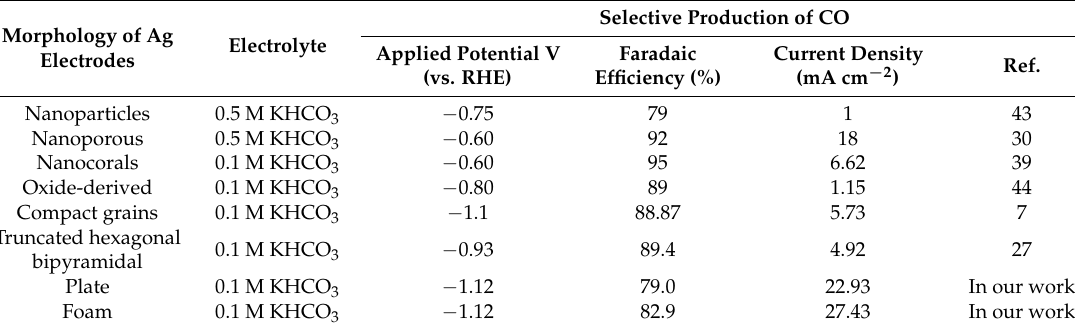
Table 3. The comparison of the activity and selectivity with different Ag